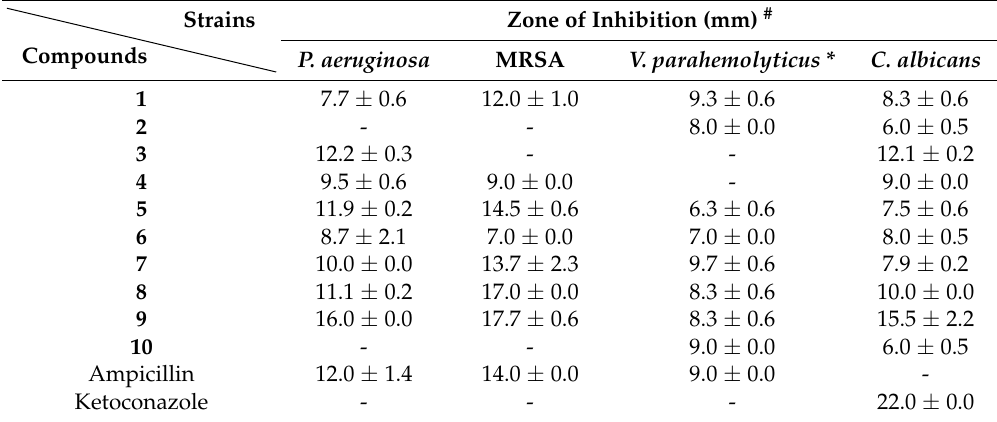
Table 2. Antimicrobial activities of compounds 1 – 10 , measured using the paper disk method. Strains Zone of Inhibition (mm) # Compounds P. aeruginosa